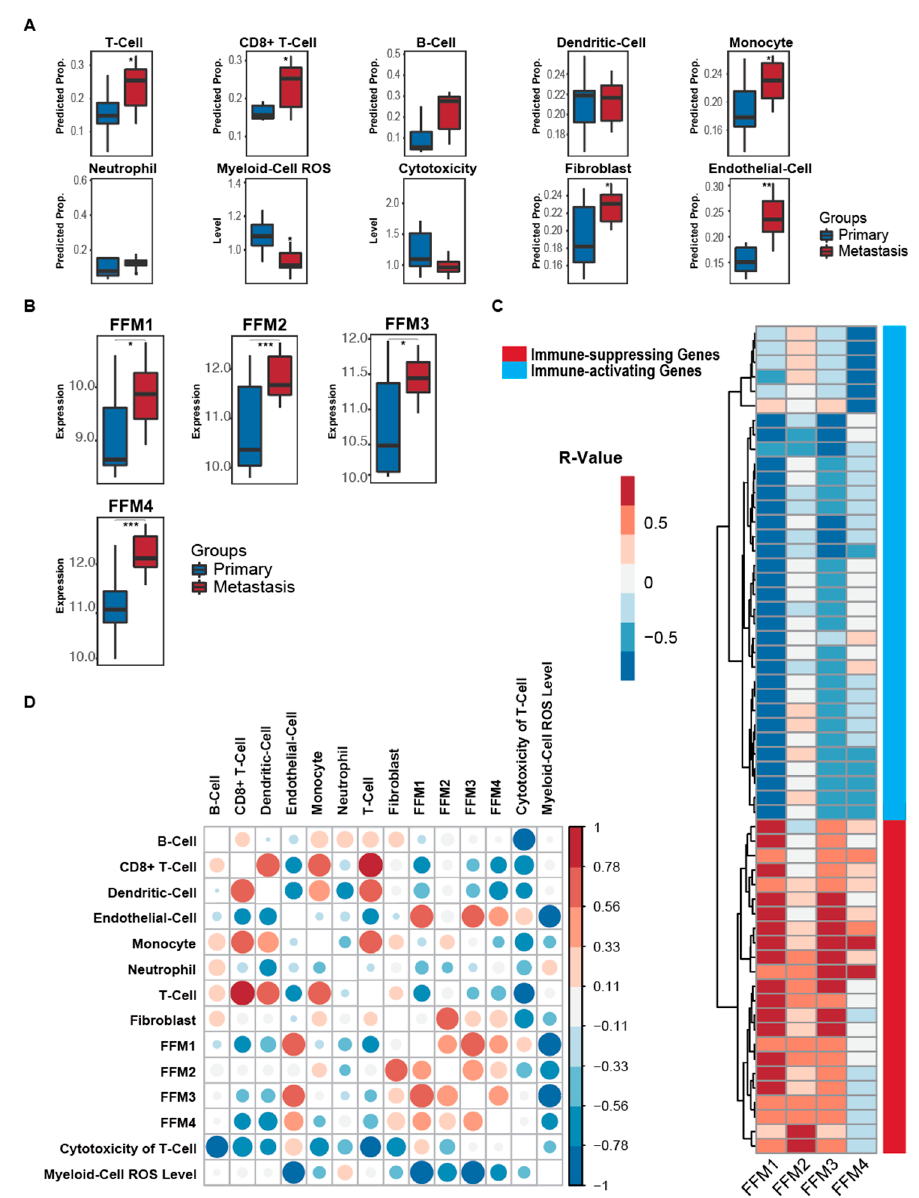
Figure 2. Characterization of the immune microenvironment and the desmoplastic stroma in OC metastasis (GSE137237). ( A ) Comparison of the predicted proportion of stromal cells in primary metastatic tumors from ovarian cancer patients. ( B ) Box plots depicting the expression levels of the 4 fibroblast functional modules (FFM1–4) in primary tumors and metastases. ( C ) Heatmap showing the Spearman correlation of 4 fibroblast functional modules and immune-associated markers in metastatic tissues. Red or blue boxes indicate positive or negative correlation between the immune-associated marker and the corresponding fibroblast functional modules (FFM1–4), respectively. Grey boxes indicate no correlation. Immune-activating or immune-suppressing markers are depicted, respectively, by the red or blue bars on the right. ( D ) A correlation analysis between the stromal cell types in the metastasis. The color scale for R -values are provided on the right. The sizes of the dots are also proportional to the magnitude of the R -value. *** p < 0.001, ** p < 0.01, * p < 0.05.